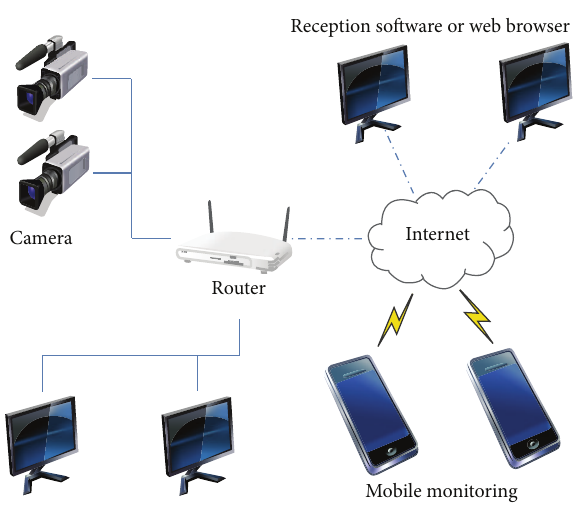
Figure 1: Network CCTV